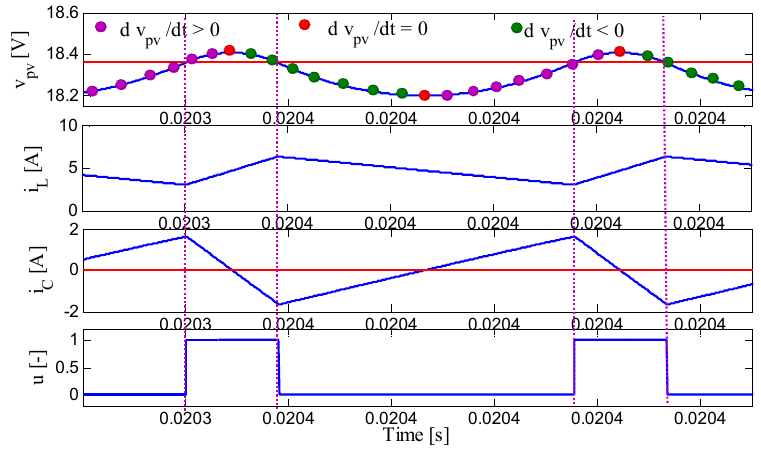
Figure 7. PV system dynamic behavior.